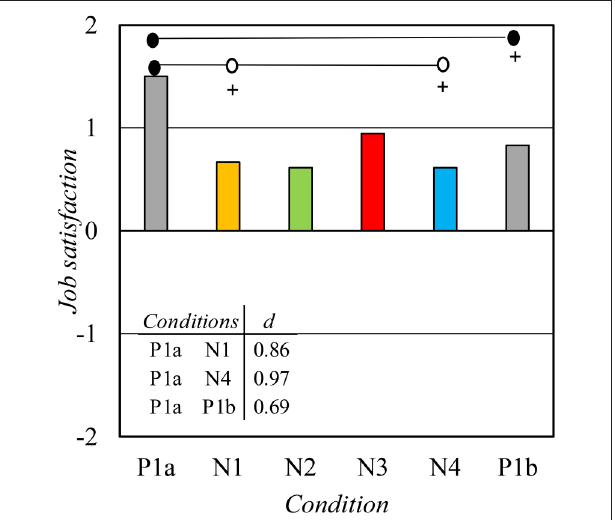
FIGURE 7 | The mean satisfaction with work as a whole. Scale as in Figure 4 . Symbol + means that the condition differs significantly from P1a ( p < 0.05).